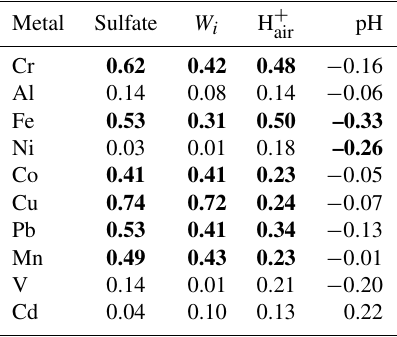
Table 1. Spearman rank correlations of the metal fractional solubil- ities with W i and H + in fine air